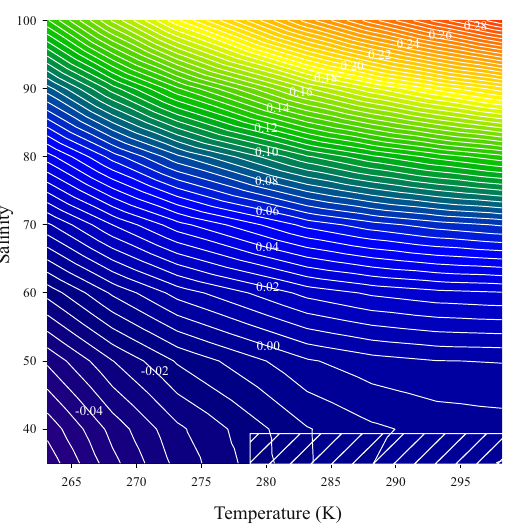
Figure 5. Temperature and salinity dependence of − k e log( ) T study from the absorbance ratio (R = A 578 /A 434 ) measurements in electrochemically characterized Tris/HCl buffers in synthetic seawater and brines (S = 35, 45, 50, 60, 70, 85, and 100) between their freezing point and 298.15 K.